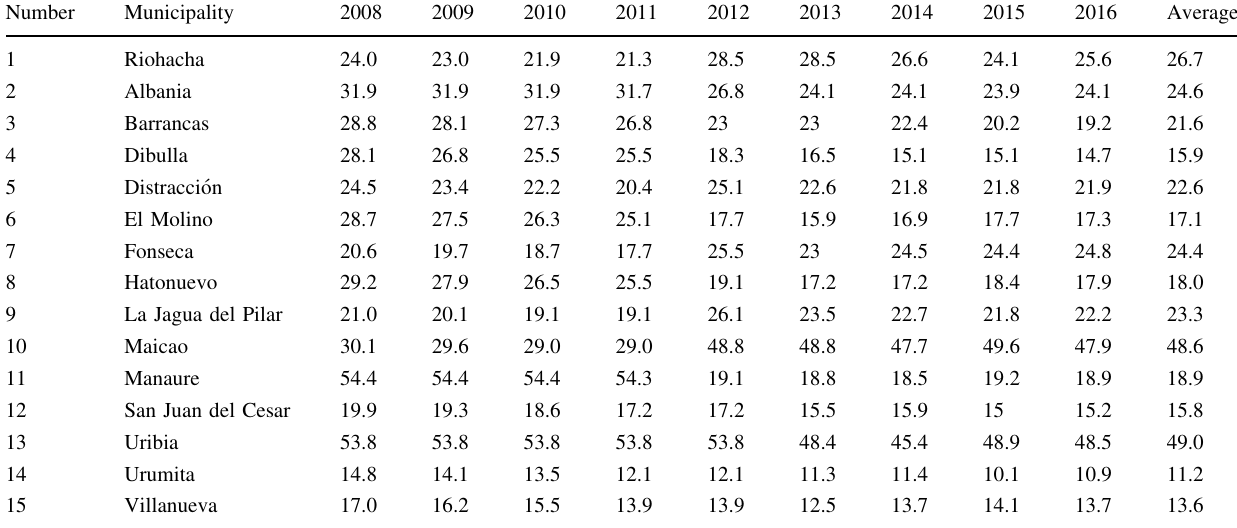
Table 1 Child mortality rates by municipality in La Guajira, Colombia. Source DANE (2017)